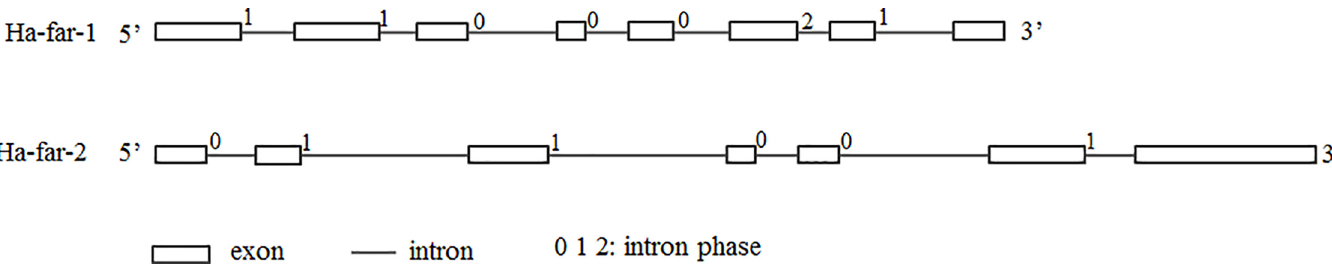
Fig 1. Structure of Heterodera avenae FAR protein genes Ha-far-1 and Ha-far-2 . The structures of Ha-far-1 and Ha-far-2 were determined by genomic DNA to cDNAs from start codon to stop codon. Exon (rectangles), introns (solid lines) and intron phase (0, 1, 2) were shown.